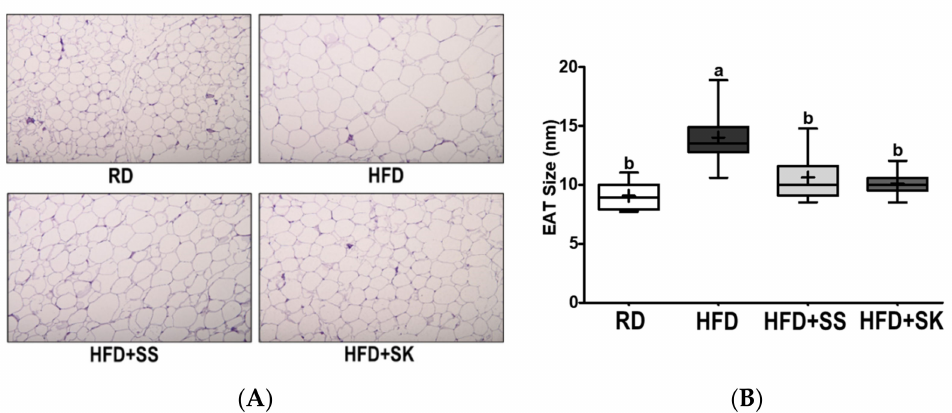
Figure 7. Effect of steamed soybean (SS) and soybean koji (SK) on epididymal adipocyte size. Experimental rats were fed a regular diet (RD) or a high-fat diet (HFD) with 3% SS (HFD+SS) or with 3% SK (HFD+SK) for 8 weeks. The epididymal adipose tissue (EAT) was stained with hematoxylin and eosin (HE). Magnification, 100 × . The EAT surface area was quantified using the Image J program. ( A ) Representative EAT images. ( B ) Quantification of the surface area of EAT. RD, regular diet; HFD, high-fat diet; HFD+SS, high-fat diet + 3% steamed soybean; HFD+SK, high-fat diet + 3% steamed soybean. Values are displayed as a box-and-whisker plot with means (expressed as ‘+’), n = 8. Data were analyzed using one-way ANOVA followed by Tukey’s post-hoc comparison. Means labeled without a common letter differ significantly, p <